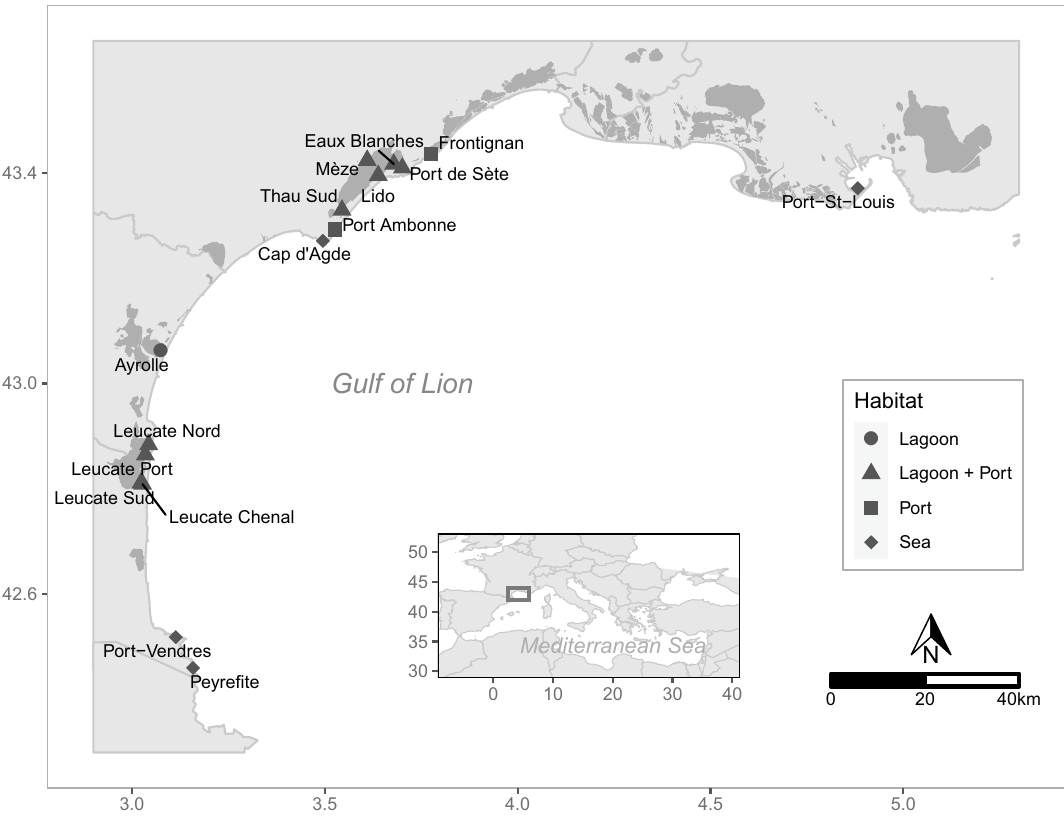
Figure 1. Location of 16 sampled sites for Pinna nobilis in the Gulf of Lion, north-western Mediterranean Sea. This map was created using R 4.0.3 (https:// www.r- proje ct. org/) using coastline and surface water data provided by https:// www. data. gouv. fr/